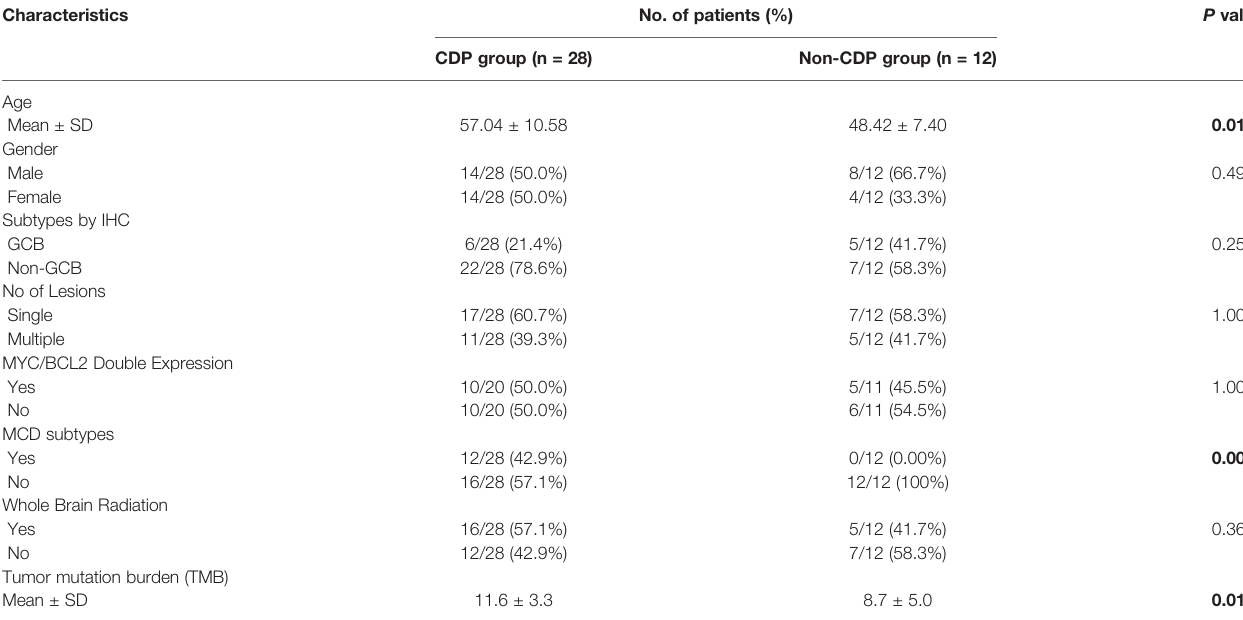
FIGURE 1 | Morphology and immunophenotype of primary CNS DLBCL. The tumor consisted of atypical cells with medium-sized to large round, oval, irregular, or polymorphic nuclei and distinct nucleoli (A) . The tumor cells expressed CD20 (B) and had a Ki67 proliferation fraction above 90% (C) . MYC (D) and BCL2 (E) double expression were found. All cases were negative for EBER ISH (F) . TABLE 1 | Patients ’ clinical characteristics between CDP and non-CDP groups.